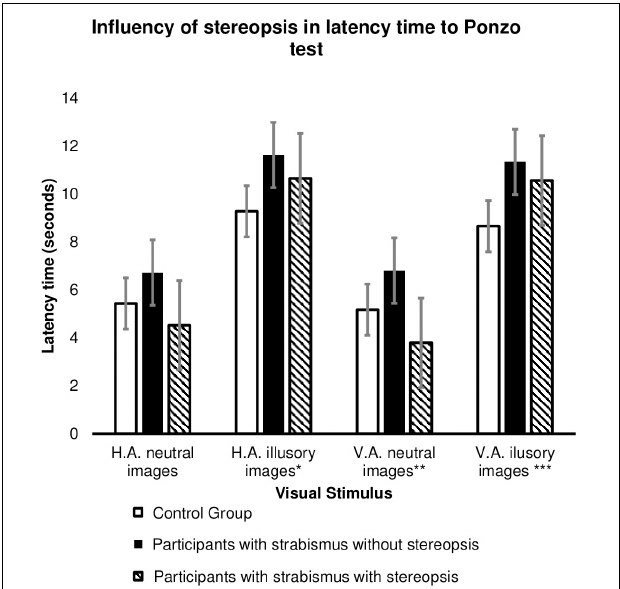
FIGURE 5 | Influence of stereopsis on image size estimation (in millimeters) in the Ponzo test between Groups: Participants with strabismus and preserved stereopsis ( n = 8), Participants with strabismus without stereopsis ( n = 37) and Controls ( n = 62). HA, horizontal adjustment images; VA, vertical adjustment images; HA illusory images p value = 0.023* (Tukey Post-Hoc p value = 0.018); VA neutral images p value = 0.037** (Games-Howeel = 0.022); VA illusory images p value = 0.028*** (Turkey Post-Hoc = 0.024). The error bars shown represent the Standard Error.